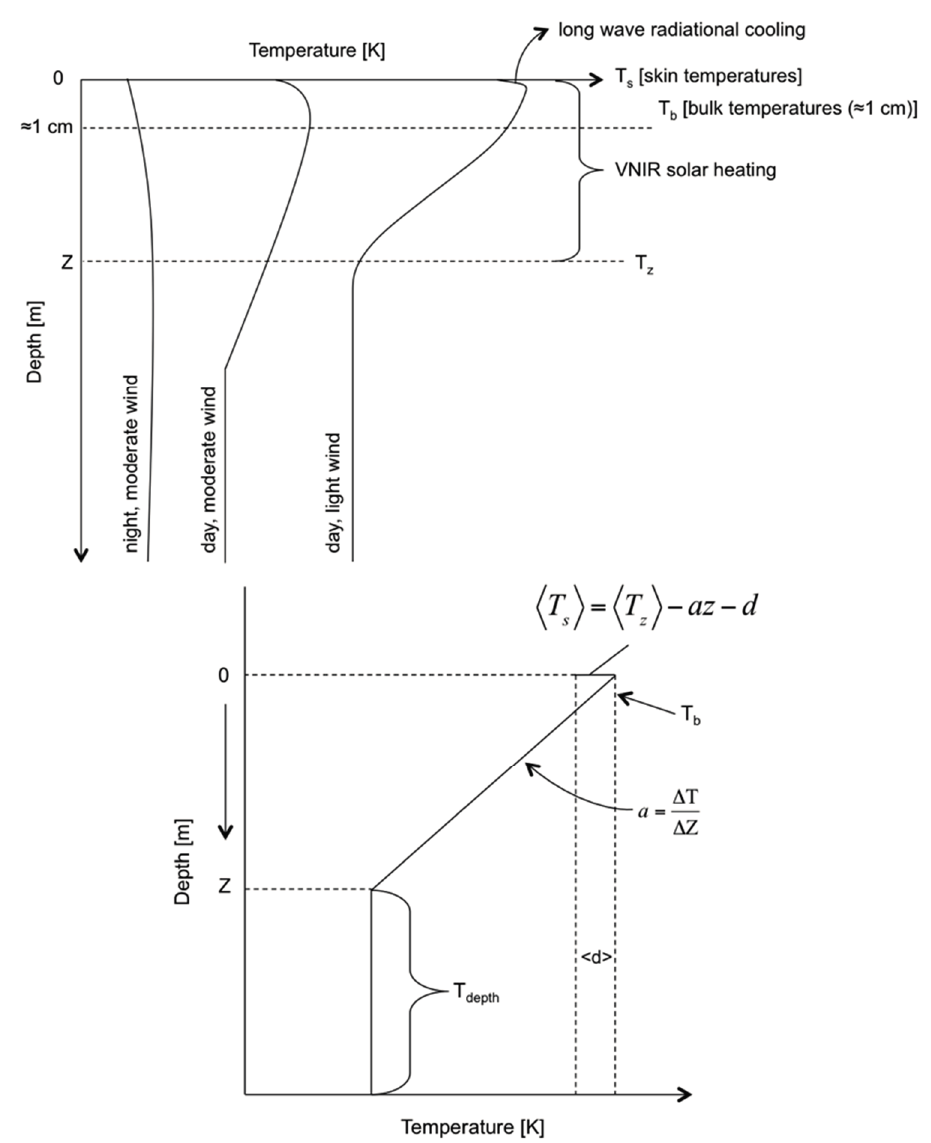
Figure 1. Illustration of parameters used in Equations (1) and (2).